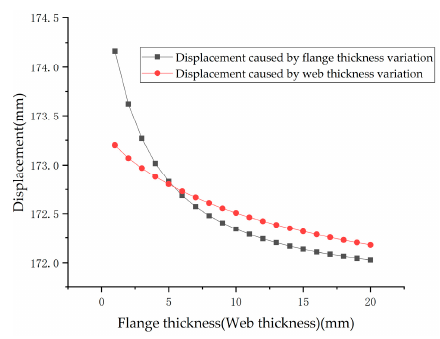
Appl. Sci. 2019 , 9 , x FOR PEER REVIEW Figure 7. Sensitivity curve of C C height and width. Figure 7. Sensitivity curve of C C height and width.